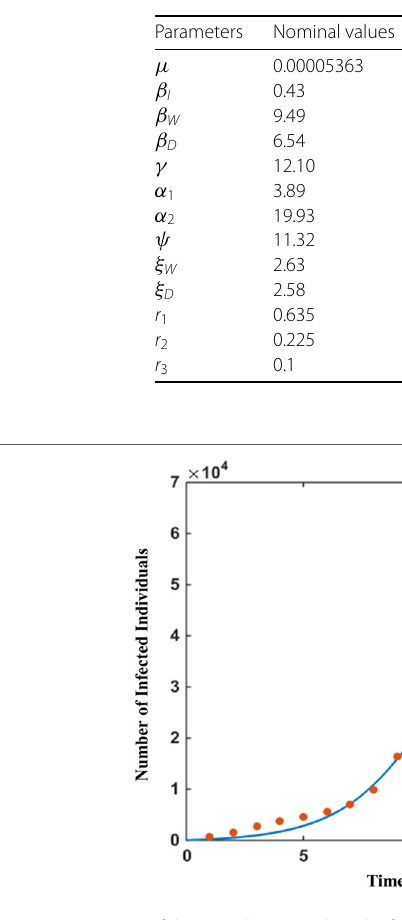
Figure 2 Comparison of the cumulative predicted infection data produced by model (3.2) and the cumulative real data from Haiti, 2010 [65]. Red points denote real data and the blue line denotes predicted